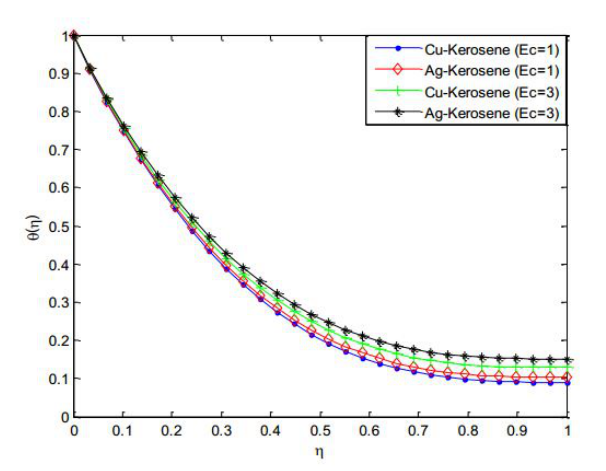
Figure 20. Effect of Eckert number on the fluid temperature distribution